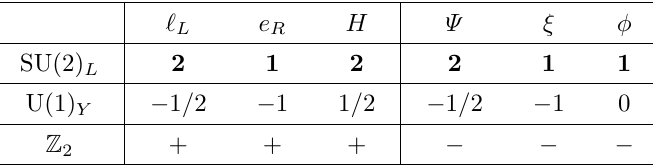
Table 1 . Quantum number assignment of the relevant fields in our model. Electromagnetic charges are given by Q = t 3 + Y